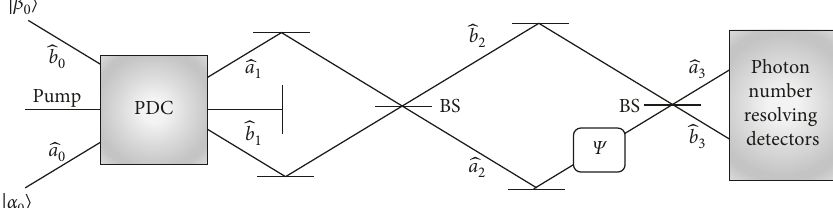
and 􏽢 b are driven by coherent 1 1